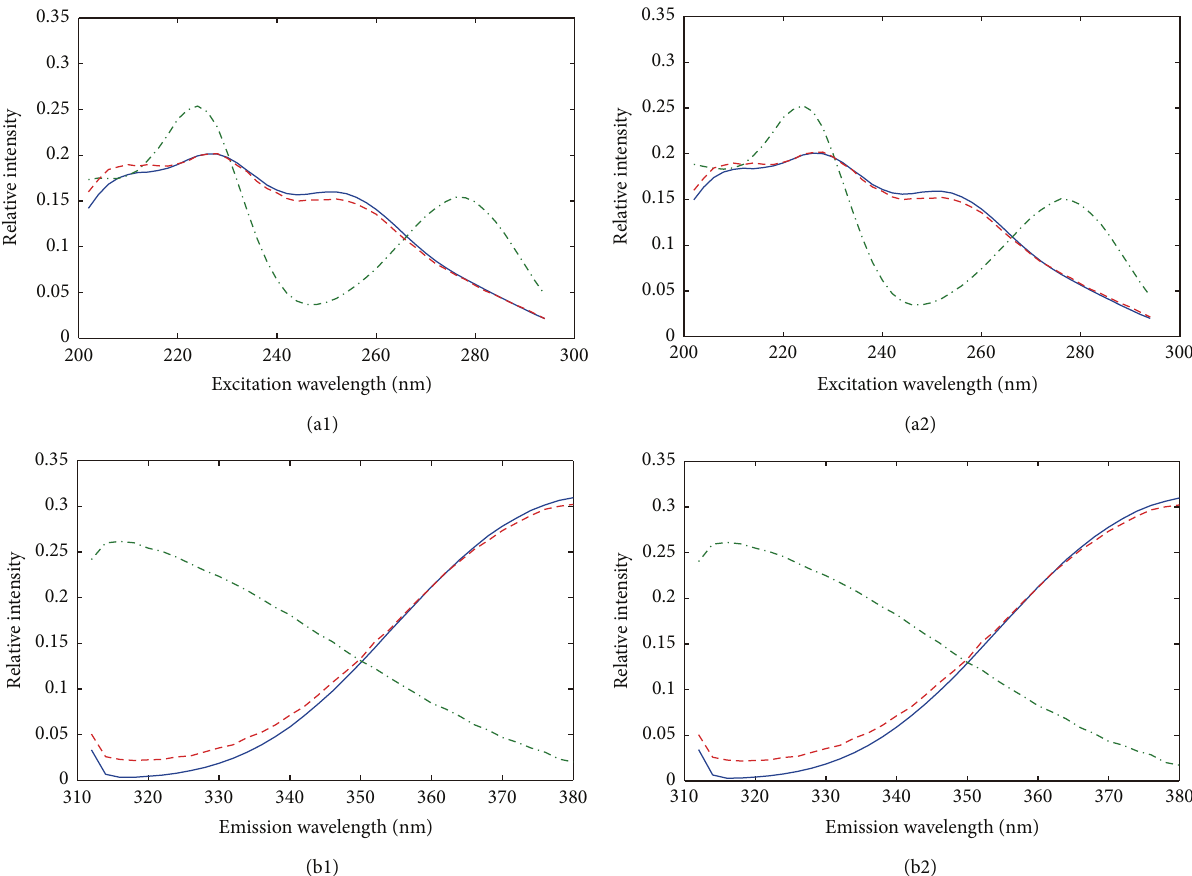
Figure 4: Actual and resolved excitation spectra (a1) and emission spectra (b1) of valsartan in human plasma using PARAFAC, and actual and resolved excitation spectra (a2) and emission spectra (b2) of valsartan in human plasma using ATLD. The solid lines, dotted solid lines, and dotted lines represented the loadings of valsartan, the loadings for an inherent interference from the human plasma, and the actual spectral profiles of valsartan,